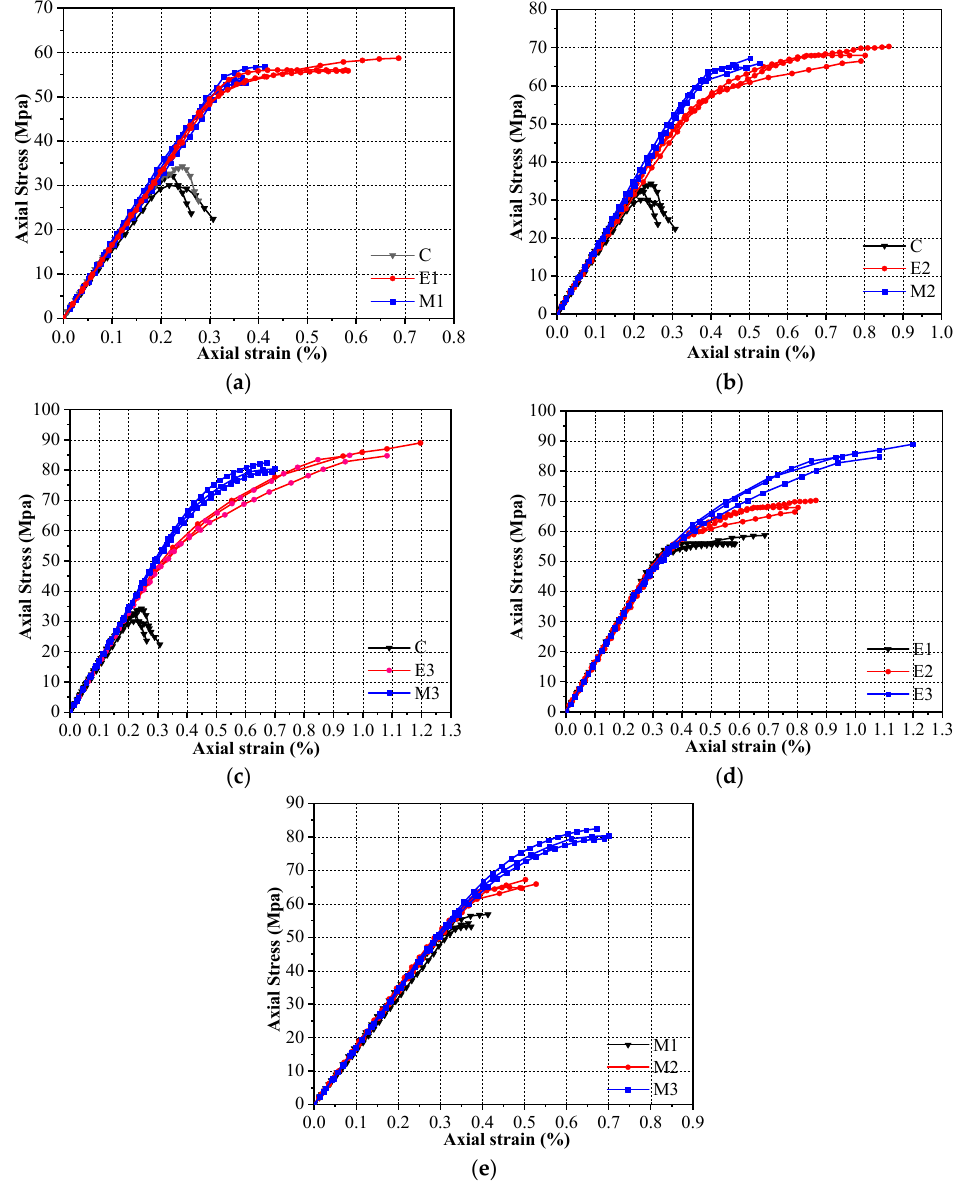
Figure 6. The stress–strain curves of the specimens confined by ( a ) one layer of fabric, ( b ) two layers of fabric, ( c ) three layers of fabric, ( d ) different layers of FRP, and ( e ) different layers of FRiP. Figure 6a–c contrasts the stress–strain curves of the FRP ‐ confined specimens with Additionally, the stiffness of the FRiP-confined specimens increases slightly with an those of the FRiP ‐ confined specimens with the same number of fabric layers. Figure 6d,e increase in the fabric content, and their degradation rate is lower than that of the